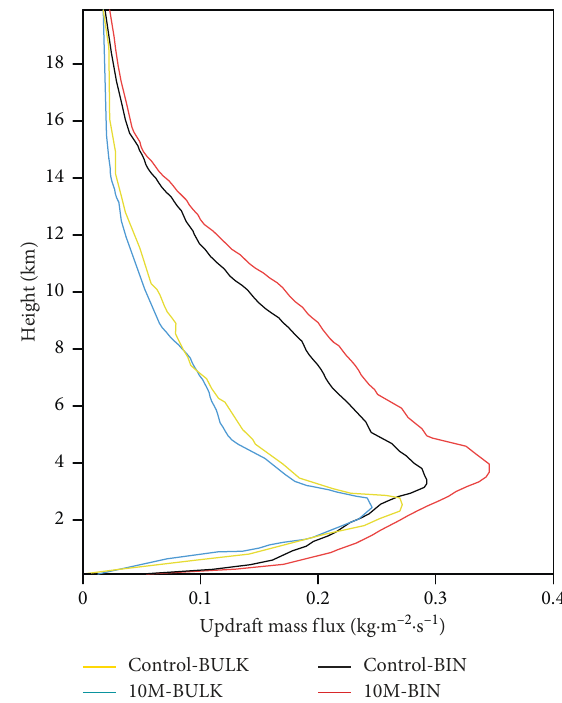
Figure 4: Vertical distributions of the time- and domain-averaged updraft mass fluxes for the standard runs (e.g., the control-BULK run, the 10M-BULK run, the control-BIN run, and the 10M-BIN